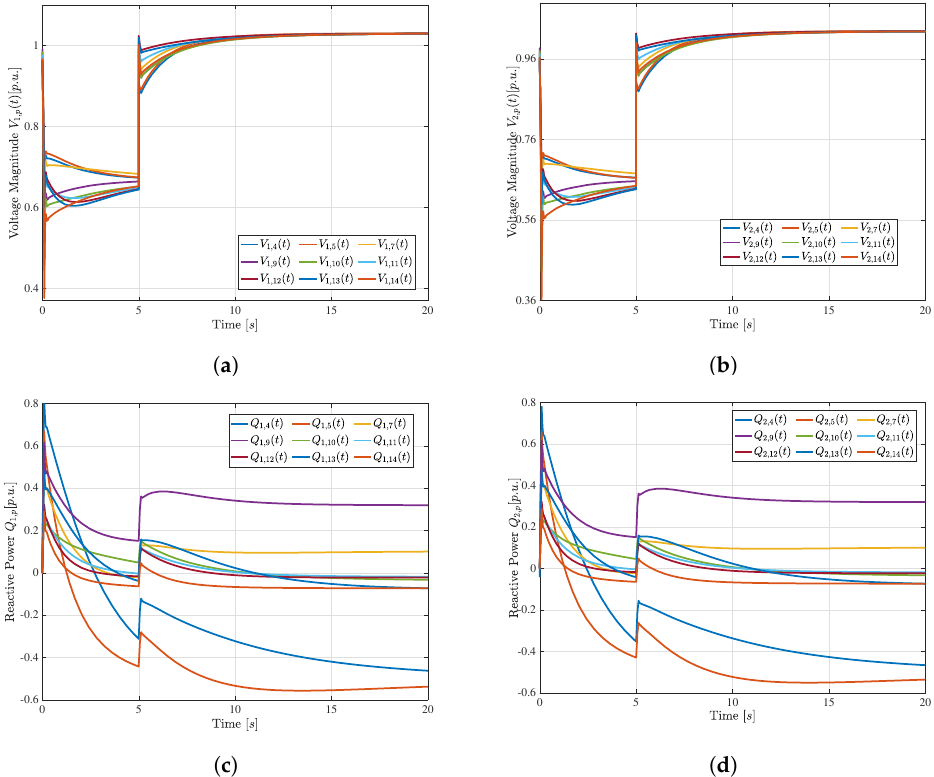
Figure 7. Comparison analysis of the proposed fully delayed Cluster Oriented Double Layer Cooperative Control with respect to the partial delayed control protocols in (17a) – (17c) involving only transmission delays in the nominal scenario. Time history of: ( a ) Voltage Values V 1, p , p ∈ N 1 c , ( b ) Voltage Values V 2, p , p ∈ N 2 c , ( c ) Reactive power of MG 1 , Q 1, p , p ∈ N 1 c , ( d ) Reactive power of MG 2 , Q 2, p , p ∈ N 2 c